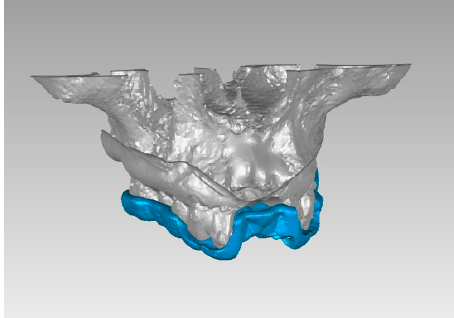
Figure 2. Matching of pre-operative CT, plaster model, and pilot drill template.